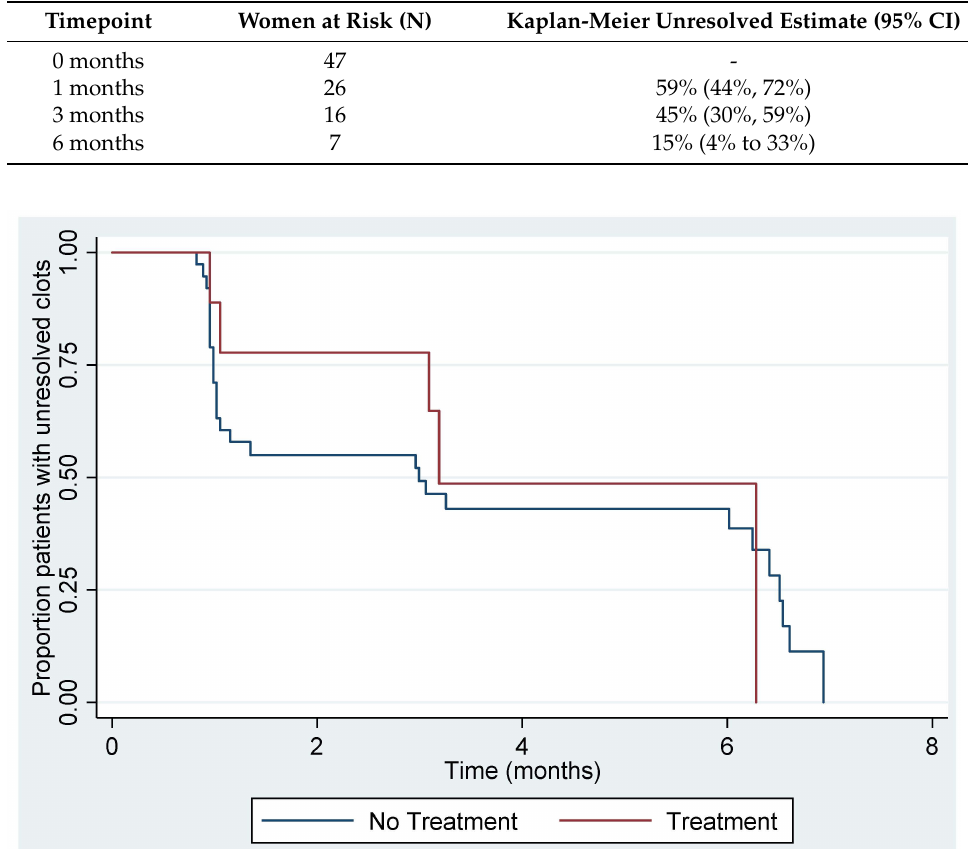
Figure 6. Kaplan-Meier plot of time to resolution between women who were managed expectantly ( n = 38) and with anticoagulation ( n =